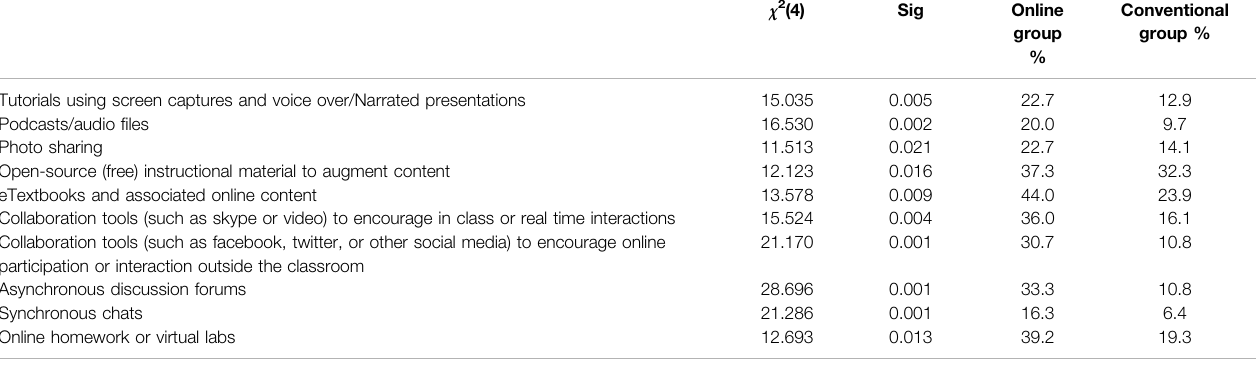
TABLE 3 | Results of chi-square analysis, and percentage of instructors in the online group and conventional group always or very often employing the following tools.